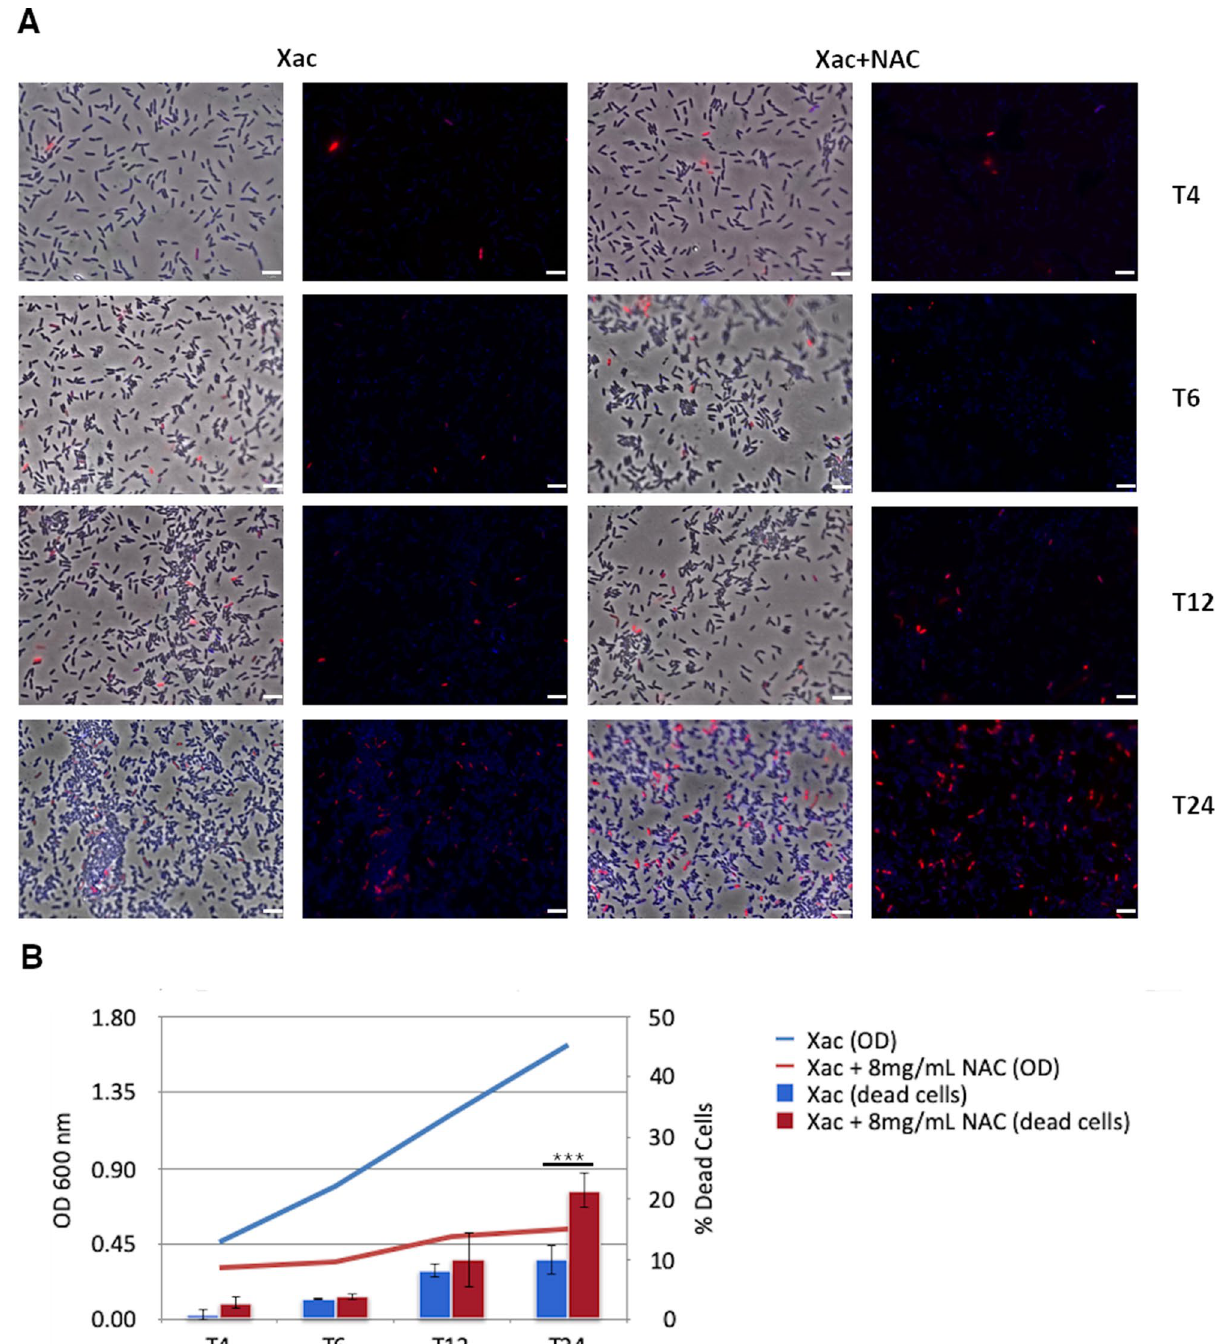
Figure 2. Cellular permeability of Xanthomonas citri subsp. citri in the presence of 8 mg/mL of N-Acetylcysteine (NAC). ( a ) Live/Dead staining was performed on X. citri cells following a 0–24 h incubation with NAC. Blue-stained cells have intact membranes, whereas red-stained cells exhibit permeabilized membranes. Magnification of × 100; the scale bars on each panel represent 5 μm. ( b ) Percentage of living or dead bacterial cells following 4–24 h exposure to 8 mg/mL of NAC. At least 1000 bacterial cells were counted under a fluorescence microscope (n > 1000). The mean of two experiments with five technical replicates is shown. Asterisks show statistically significant differences using t -Student (*** P < 0.001). Error bars represent the standard errors of the